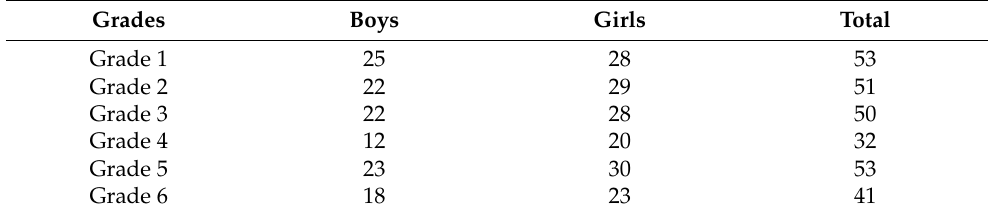
Table 3. Basic information of